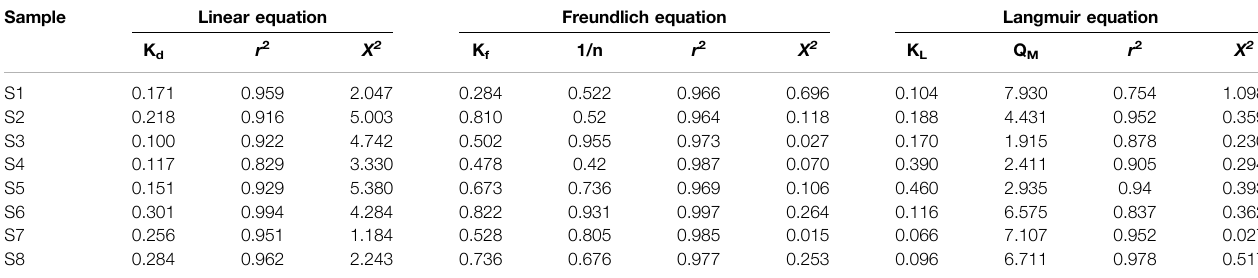
TABLE 3 | Parameters of the linear, Freundlich, and Langmuir equation for the sorption of atrazine into soil in the study area. Sample Linear equation